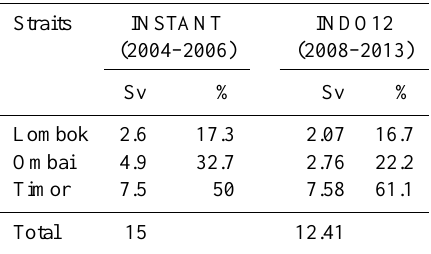
Table 2. Mean volume transport in the ITF (Sv and Ratio) for Lom- bok Strait, Ombaï Strait and Timor passages. Mean values from INSTANT (2004–2006) and from the INDO12 simulation (2008– 2013).